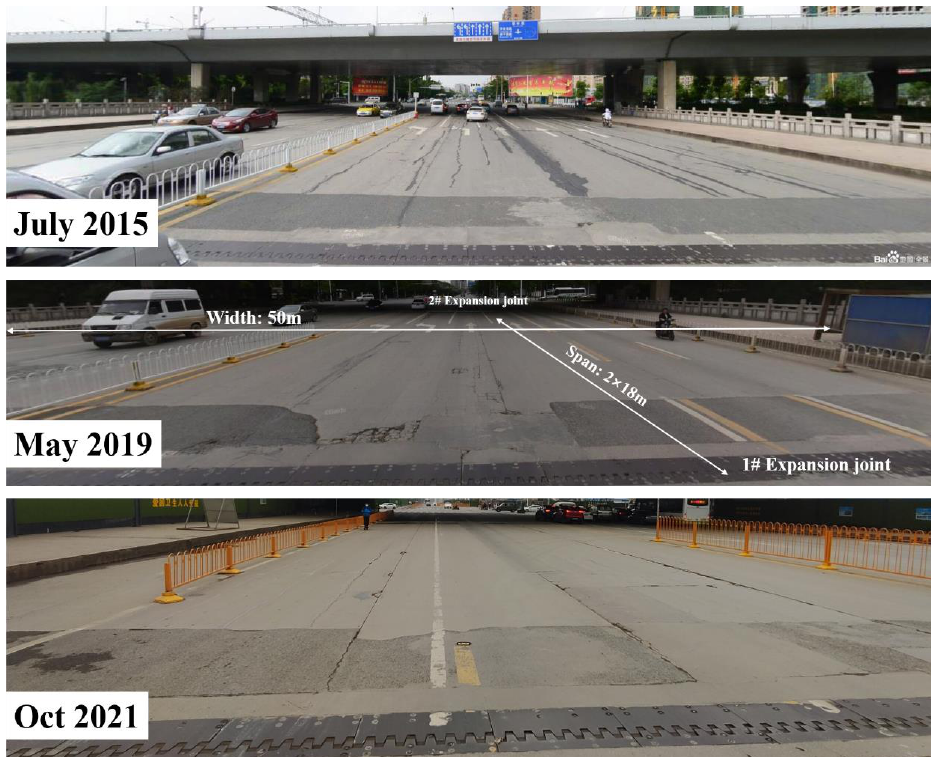
Figure 5. Appearance of Luojiagang